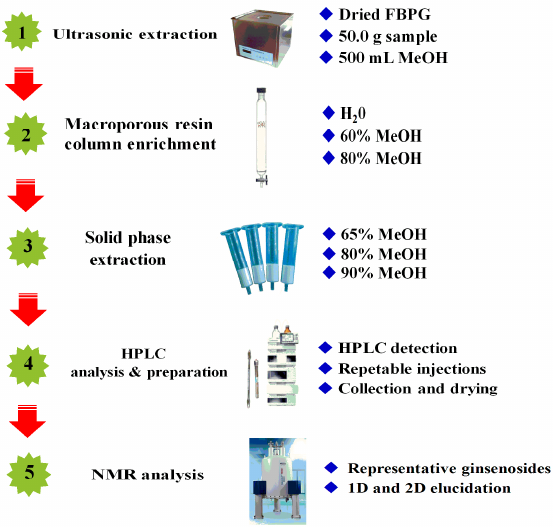
Figure 1. A flowchart of our integrated strategy for isolation and purification of novel ginsenosides from the flower buds of Panax ginseng (FBPG). HPLC, high-performance liquid chromatography.